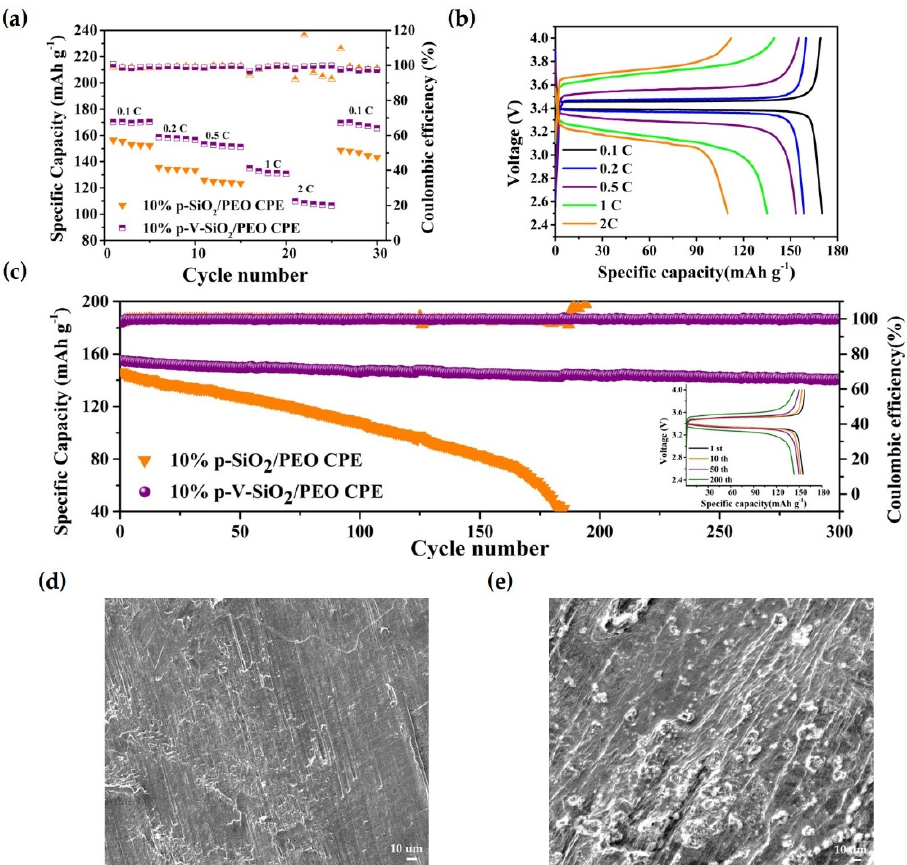
Figure 6. ( a ) Rate capability at different current densities at 60 °C. ( b ) Charge–discharge profiles of Li|10% p-V-SiO 2 /PEO CPE|LiFP cells at different current densities at 60 °C. ( c ) Cycle performance of Li|10% p-V-SiO 2 /PEO CPE|LiFP cells at 0.5 C at 60 °C. The insert image is the charge–discharge profiles of Li|10% p-V-SiO 2 /PEO CPE|LiFP cells under different cycle numbers. ( d , e ) The SEM images of Li electrodes from Li|LiFePO 4 cells with 10% p-V-SiO 2 /PEO CPE and 10% p-SiO 2 /PEO CPE after 150 cycles, respectively.